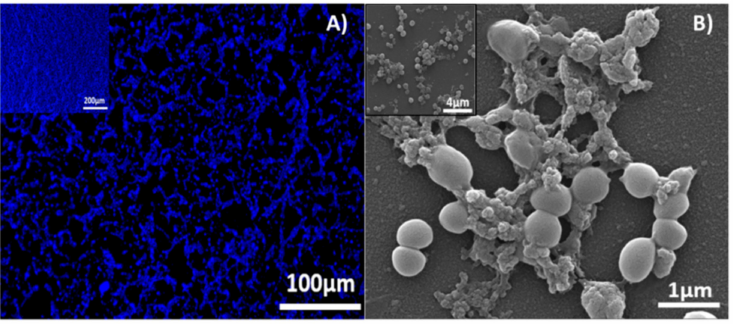
Figure 4. Calcofluor staining ( A ) and SEM images of S. aureus biofilm formed after 16 h ( B ).